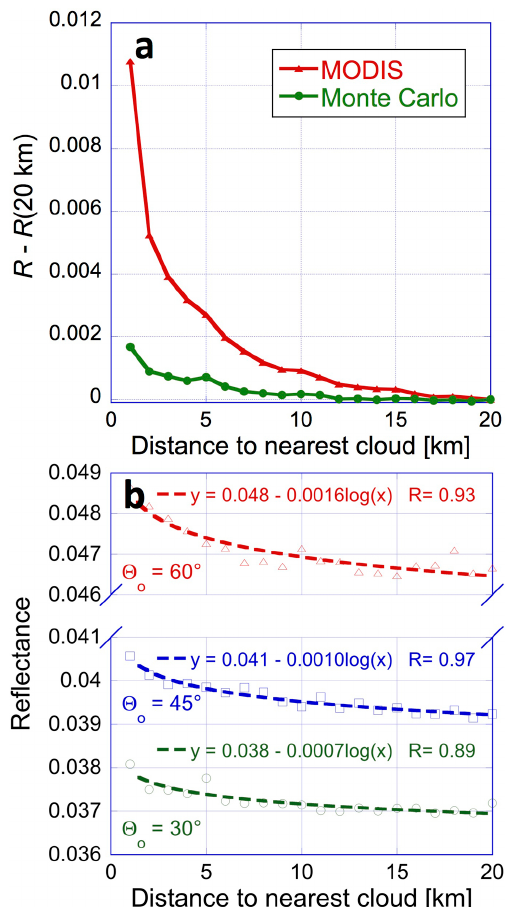
Fig. 5. (a) Comparison of 0.55µm mean reflectance enhancements observed by MODIS and simulated by a Monte Carlo model that considers the Rayleigh scattering component of 3-D radiative pro- cesses. Enhancements are defined as the difference from the mean value observed 20km away from clouds. The plot is based on all oceanic areas between 60 ◦ N and 60 ◦ S that MODIS observed along the CALIOP track between November 2006 and October 2007. (b) Subsets of the Monte Carlo simulation results in Panel a for three solar zenith angle ( 2 o ) values. Dashed lines show logarith- mic fits to the